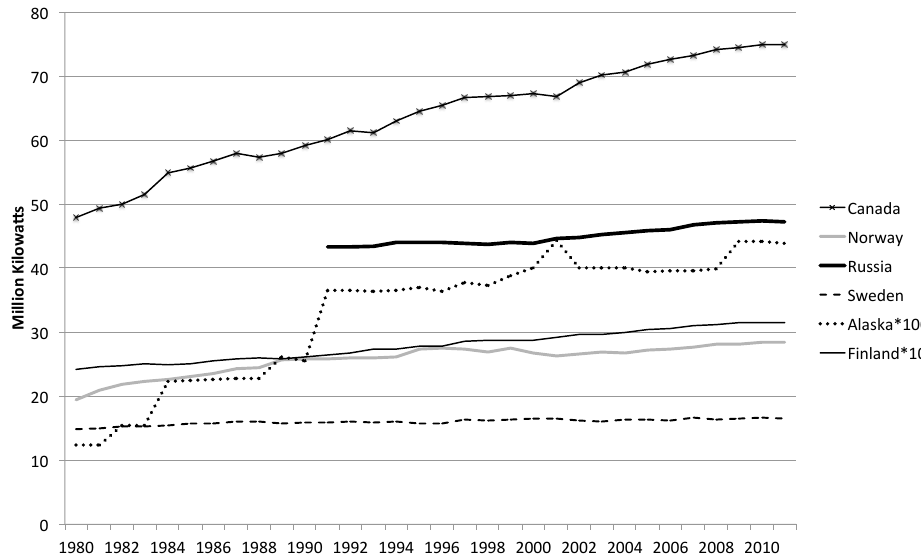
Figure 3. Trends in hydropower capacity in selected northern regions, 1980–2012. Data are from the Energy Information Administration and the Alaska Energy Data Gateway. Capacity statistics in Alaska and Finland have been multiplied by factors that make them easier to visualize on the same graph as the other data.